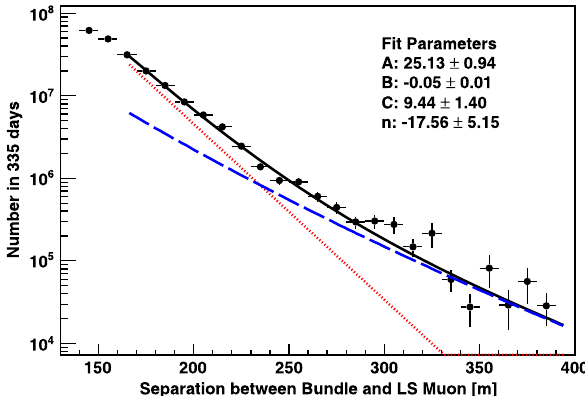
Fig. 15 The lateral muon distribution measured by IceCube, nor- malised to sea level, along with the best fit parameters to a combined exponentialandpowerlawfunctionoftheformexp ( A + Bx ) + 10 C ( 1 + x / 400 ) n . The exponential part of the fit is plotted as a dotted red line and the power law is shown as a dashed blue line. Figure reprinted with permission from [106] (Copyright 2013